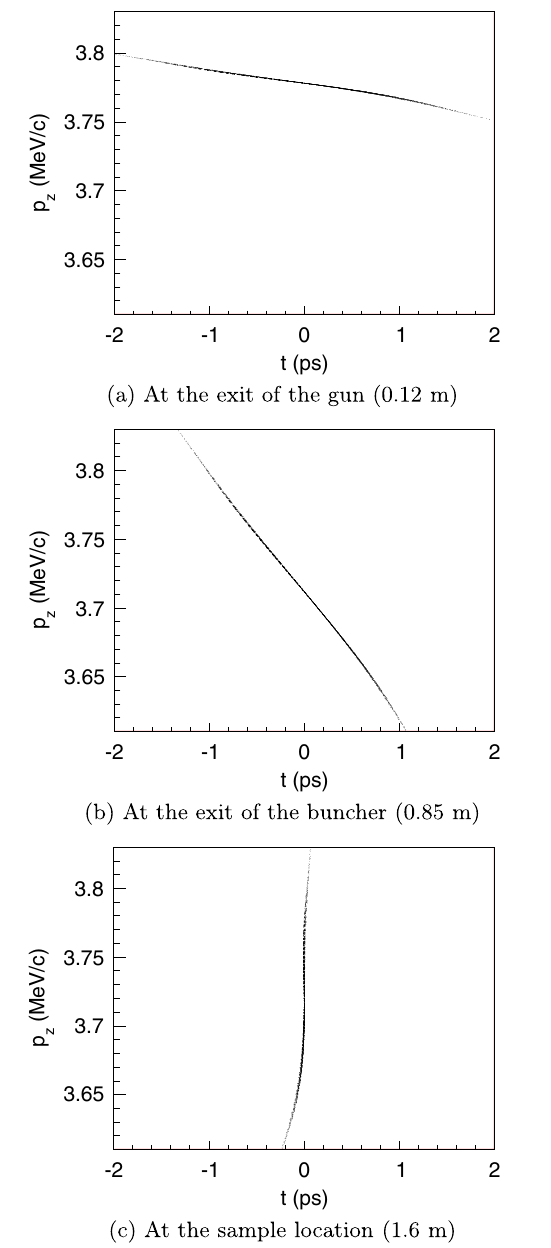
FIG. 5. Beam longitudinal phase space at three locations. At the exit of the gun (a), the beam head has a lower energy than the tail and the length becomes gradually shorter by weak velocity bunching. When the beam passes through the buncher (b), the energy chirp is increased so that the beam can be strongly velocity compressed. The maximum peak current is achieved at 1.6 m (c) where the central slices are aligned